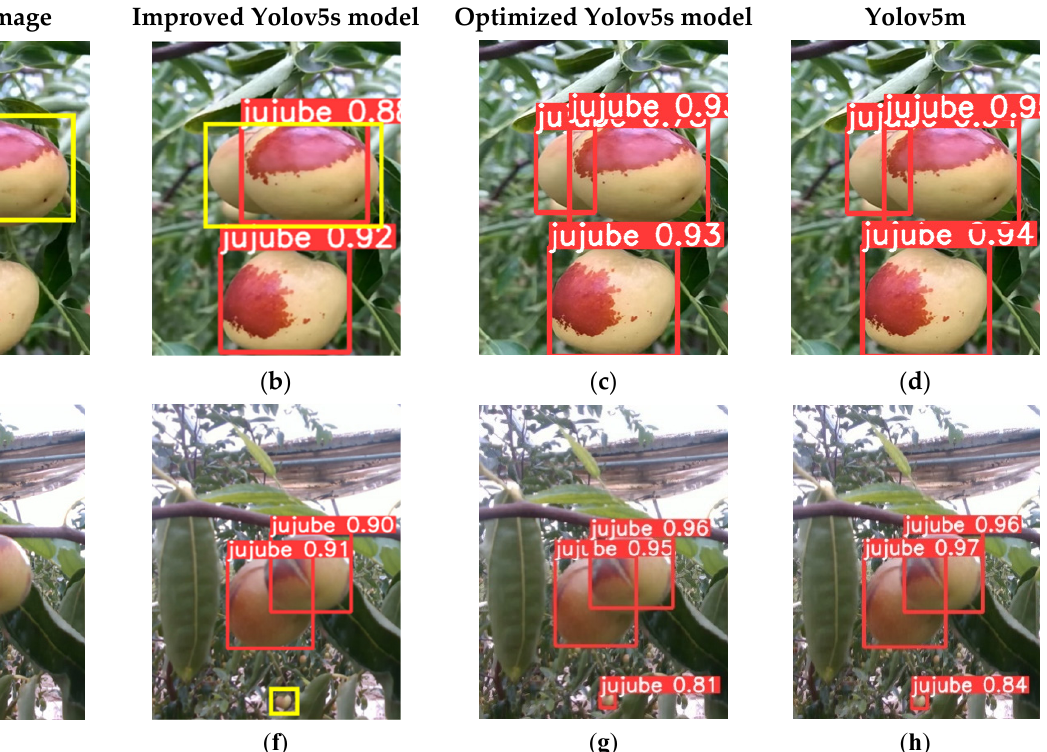
Figure 9. Original image and the results of different models for the recognition of jujube: ( a ) the original image of large area obscuring jujube; ( b ) the improved Yolov5s model to large area obscuring